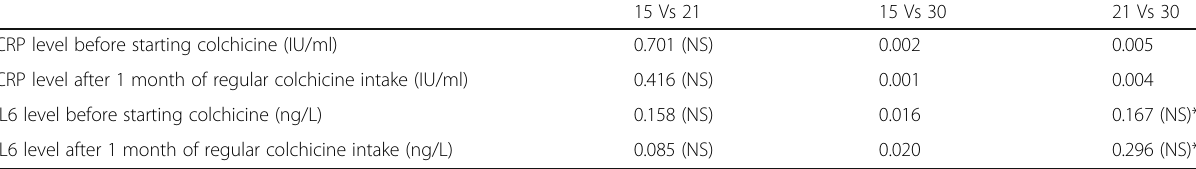
Table 5 P value using post hoc analysis by LSD method for comparing IL6 and CRP levels in the 3 penicillin